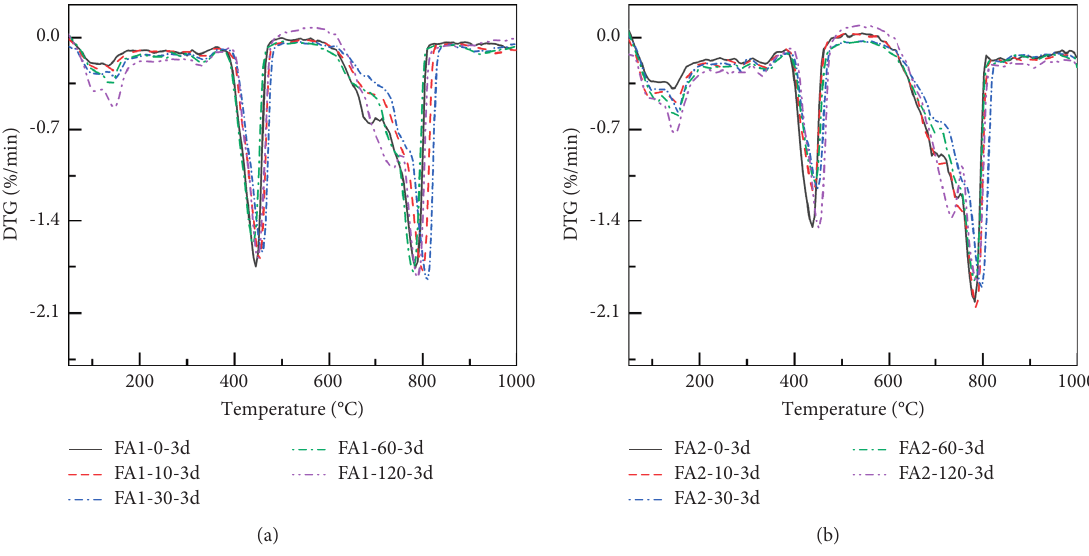
Figure 8: DTG analysis results of the hydrated samples after three days: (a) FA1 and (b)